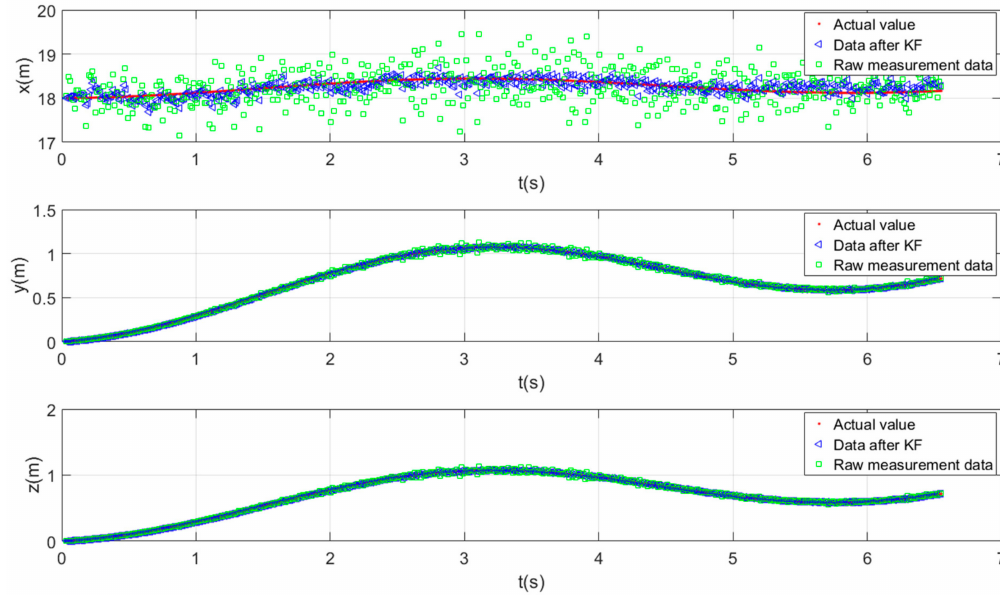
Figure 13. Simulated localization results as functions of